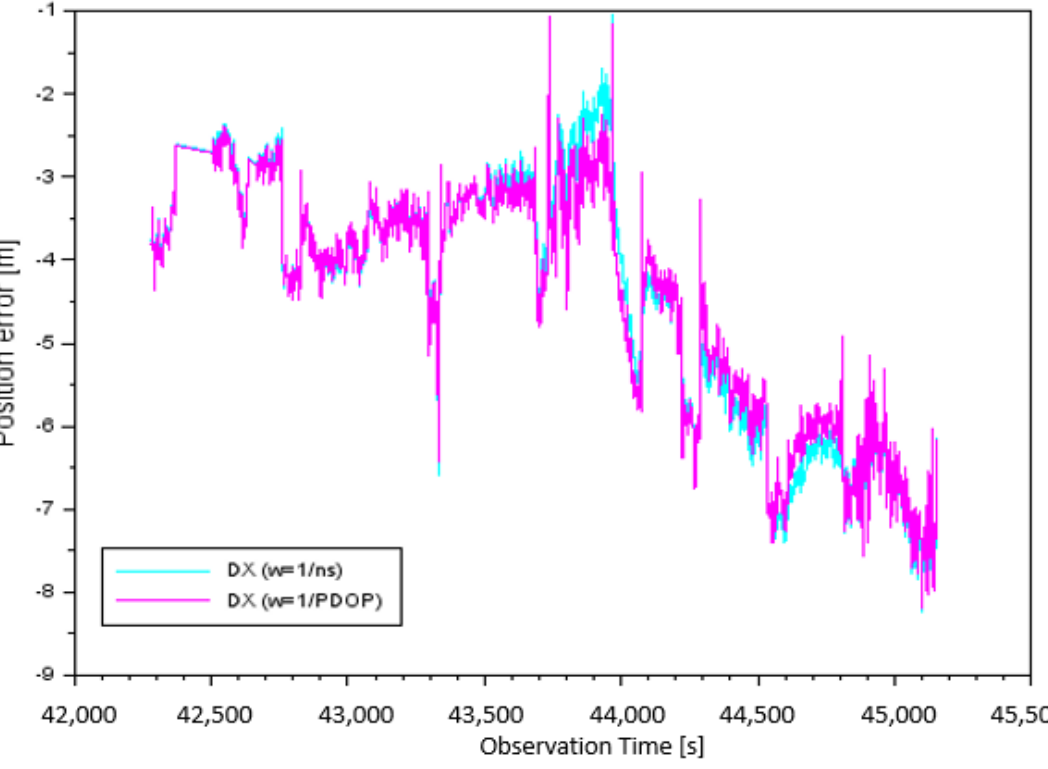
Figure 4. Position error along the X-axis.